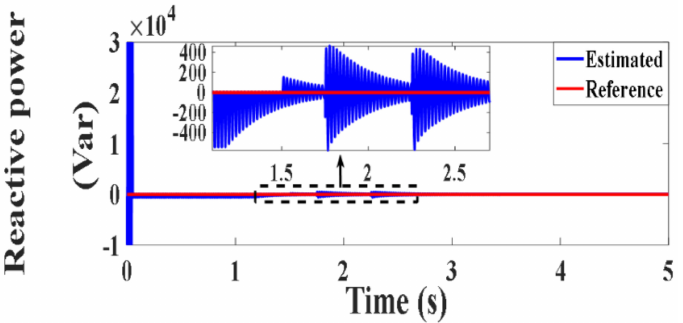
Figure 11. Reactive power under SVOC (var).